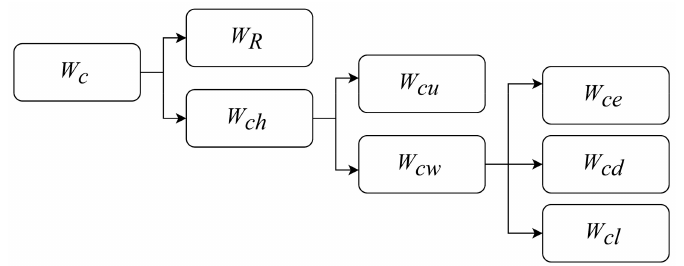
Figure 4. Schematics of energy